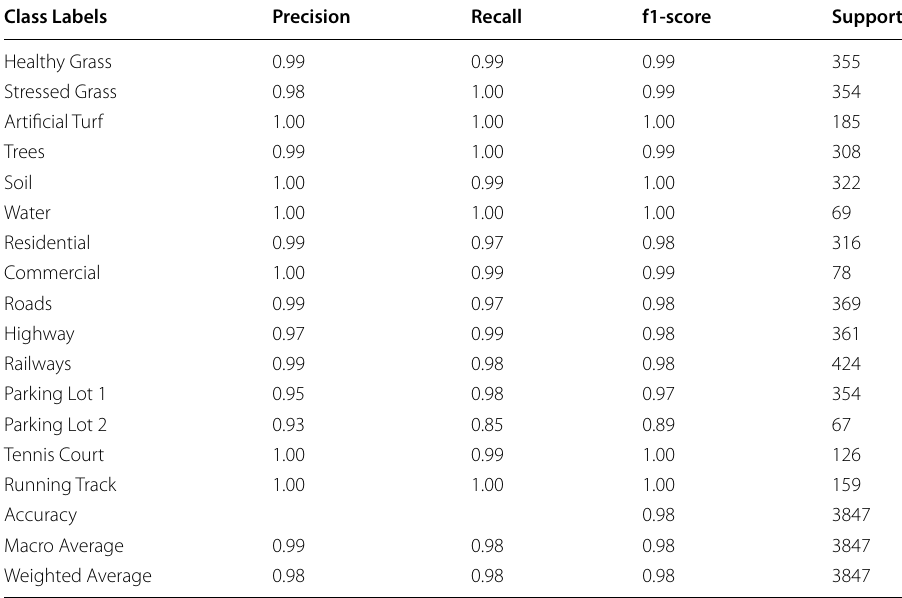
Table 17 Detailed classification test results for the Houston Dataset in terms of Precision, Recall, and F1-Score. Testing was done with PCA 30 CEU-Net no-patching with a 75%/25% Training/Testing split